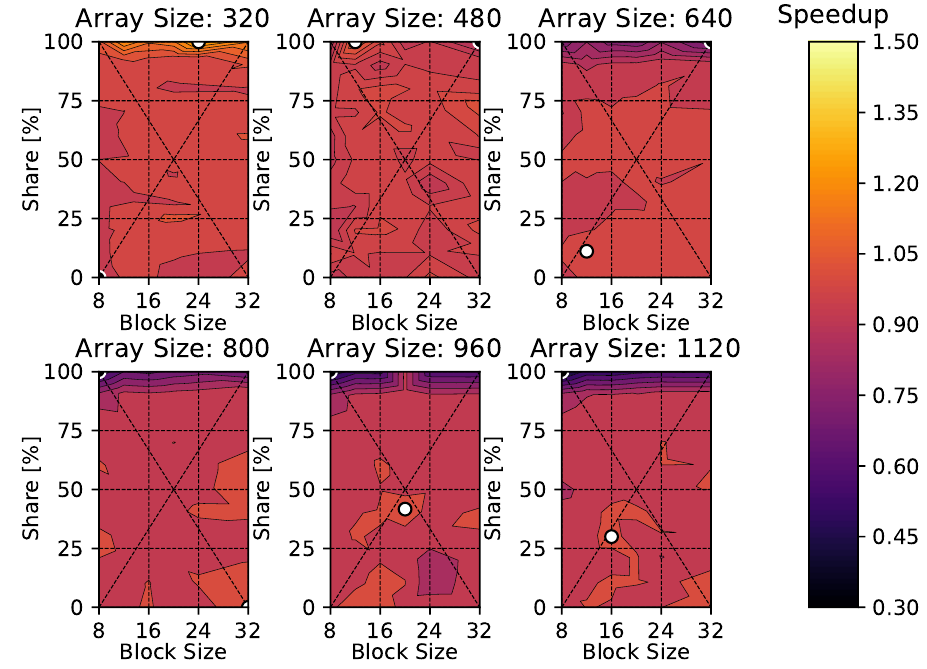
Figure 9. Swept rule speedup results for the compressible Euler equations with GeForce GTX 1080 Ti GPUs and Intel Skylake Silver 4114 CPUs.